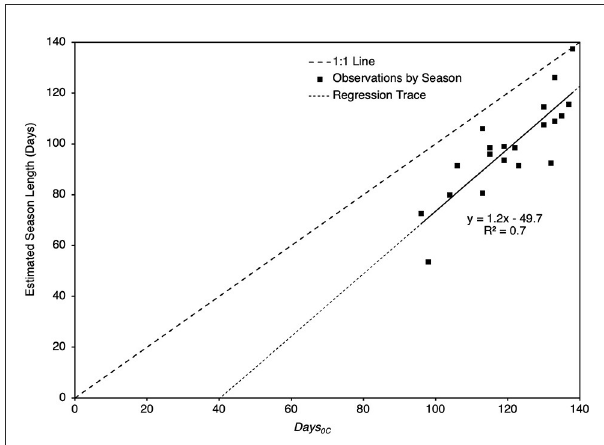
FIGURE4 The comparison of Days 0 C and estimated season length. Days 0 C is always lower than the 1:1 line, suggesting the parameter is a “ceiling” variable for the presence of ice